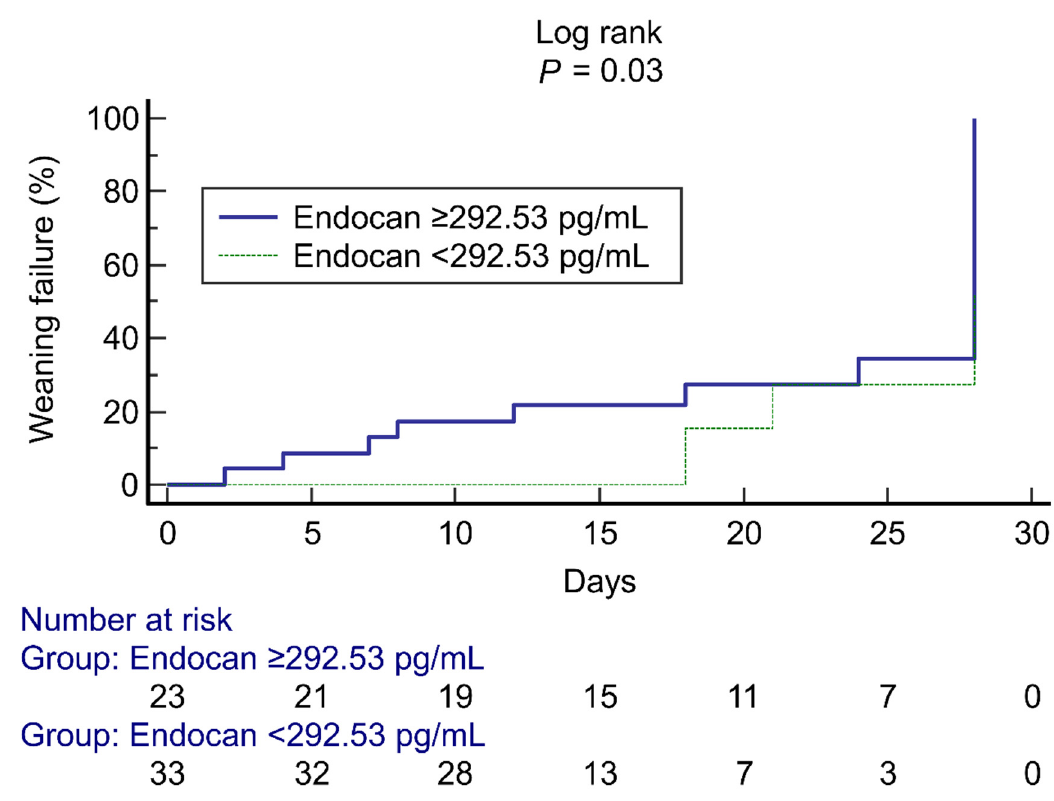
Figure 3. Kaplan-Meier curves showing the cumulative number of weaning failure (death or discharge with oxygen support) patients before day 28 after hospital admission based on a 7-day increase in endocan. The bottom of the figure shows the number of patients with severe COVID-19 admitted over time. COVID-19: coronavirus disease 2019.